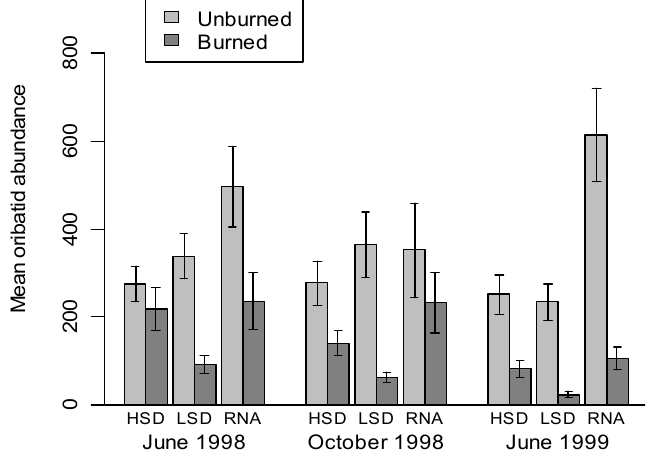
Figure 3. Mean abundance of oribatid mites ± 1.0 SE in burned and unburned split-plots from high structural diversity treatment stands (HSD), low structural diversity treatment stands (LSD), and Research Natural Area reference stands (RNA) during each of the three sampling periods (June 1998, October 1998, and June